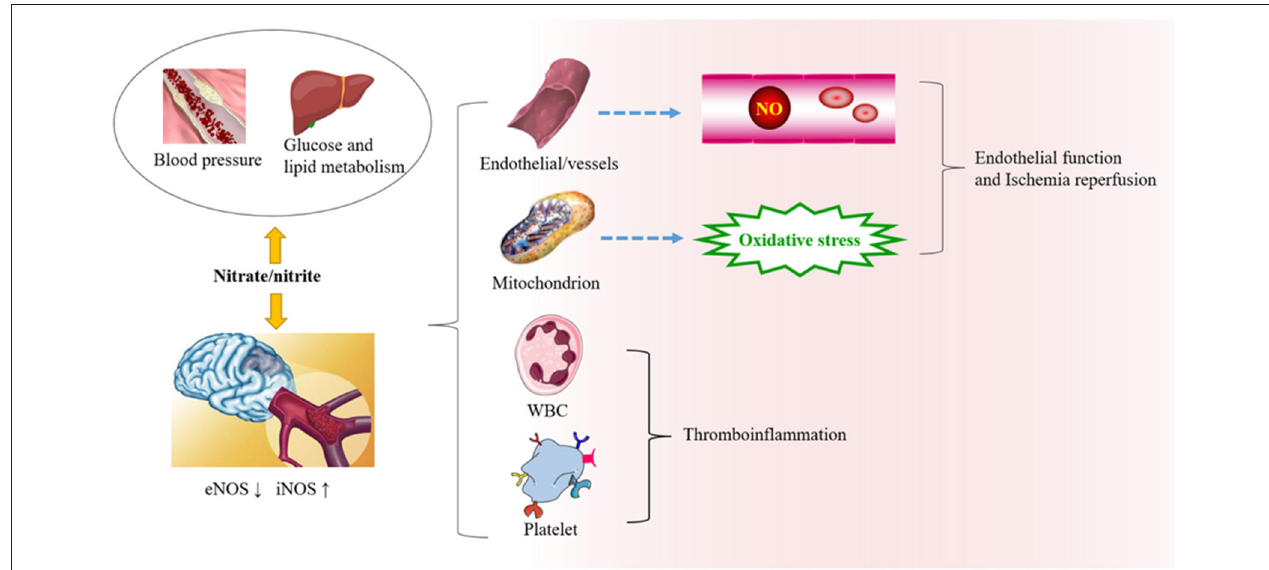
FIGURE 2 | The role of nitrate/nitrite in ischemic cerebrovascular disease. In ischemic cerebrovascular disease, endothelial nitric oxide synthase (eNOS) is downregulated, while iNOS is upregulated. Beneficial NO is thereby reduced, and oxidative stress is increased. Exogenous supplementation of nitrate from food sources has great potential in protecting against oxidative damage, endothelial dysfunction, and thromboinflammation. It can also affect the risk factors related to ischemic cerebrovascular disease, such as blood pressure, blood lipid metabolism, and so